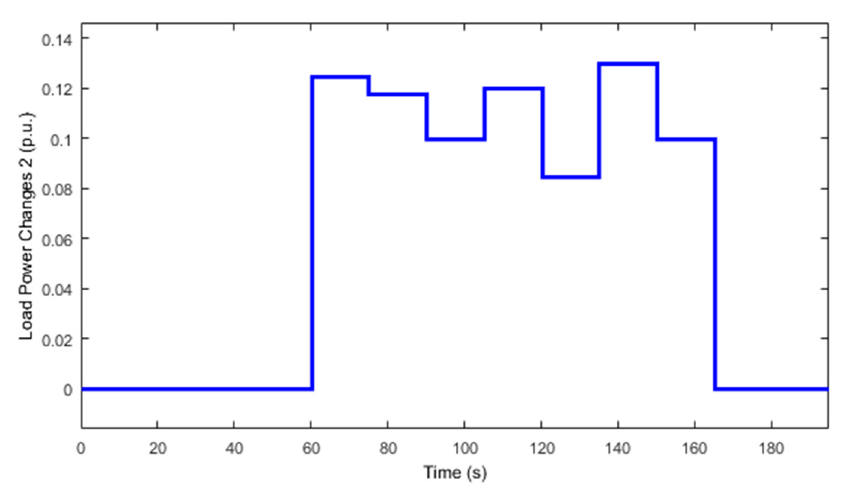
Figure 9. Load power.